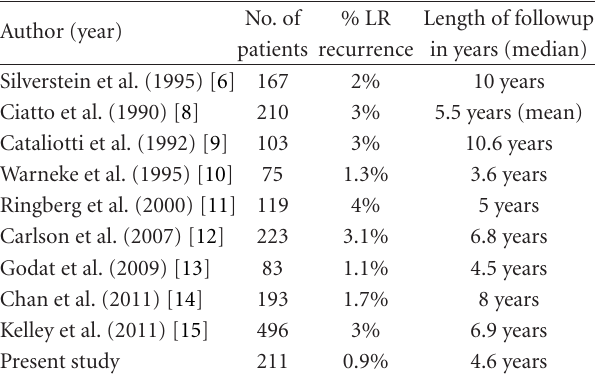
Table 2: Local recurrence in DCIS following mastectomy— summary of